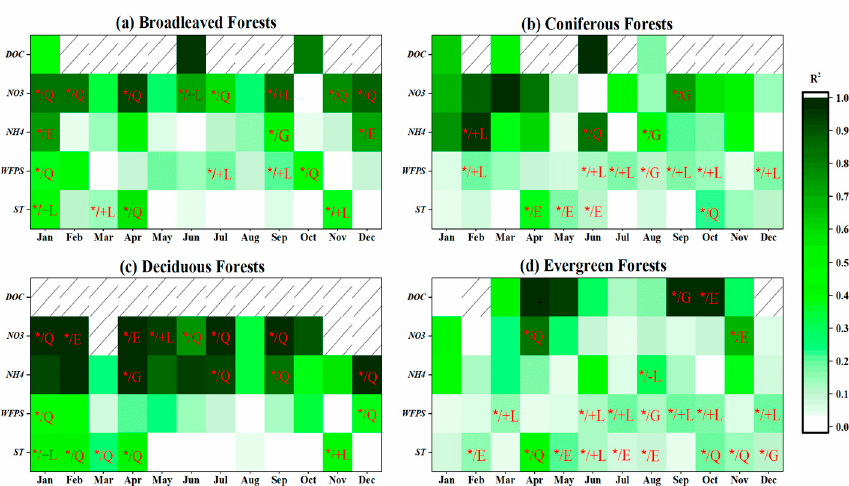
Figure 6. Heat map of the coefficients of determination ( R 2 ) of linear regression (L), quadratic regression (Q), logarithmic regression (G) or exponential regression (E) between N 2 O fluxes and soil temperature (ST), WFPS, NH4 (NH 4+ concentration), NO3 (NO 3- concentration), and DOC (DOC concentration) for ( a ) broadleaved forests, ( b ) coniferous forests, ( c ) deciduous forests, and ( d ) evergreen forests of each month. *Represents the significant relationship; +L and –L represent the positive and negative linear correlations, respectively.